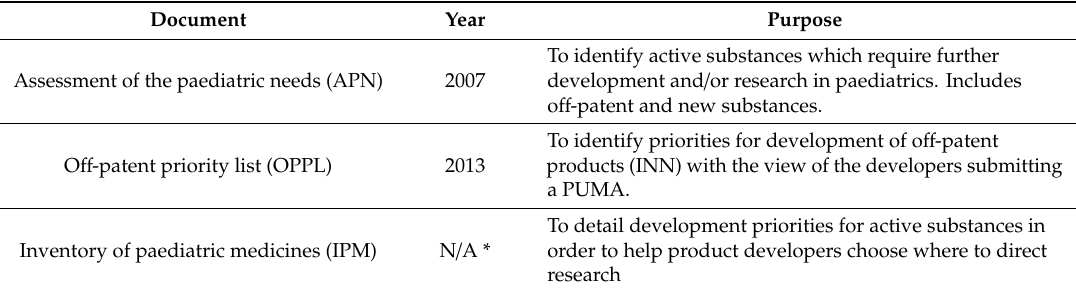
Table 2. The three documents produced by the EMA outlining paediatric medicinal needs as described at the EMA website [16,17]. * Therapeutic areas in the inventory are being published one by one with